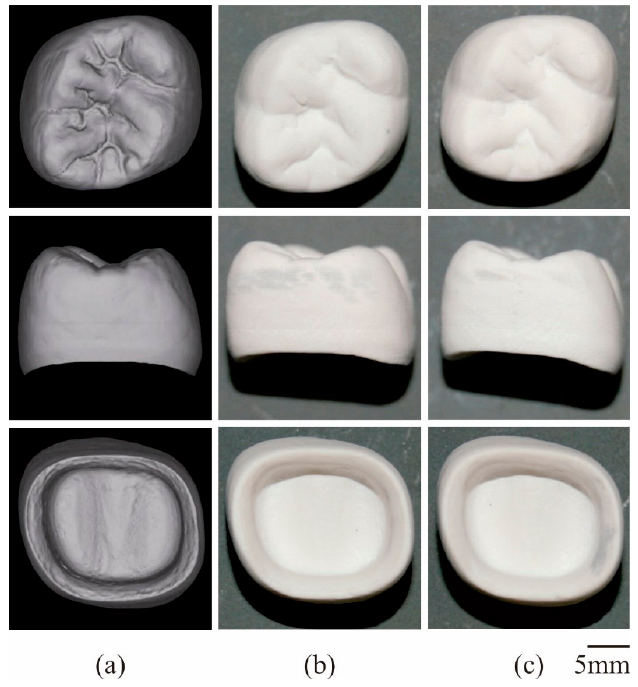
Figure 9. Dental crowns fabricated by STL-AM. Top and side views of the graphic model ( a ); composite precursor ( b ), and ceramic component ( c ) arranged in the same magnification.